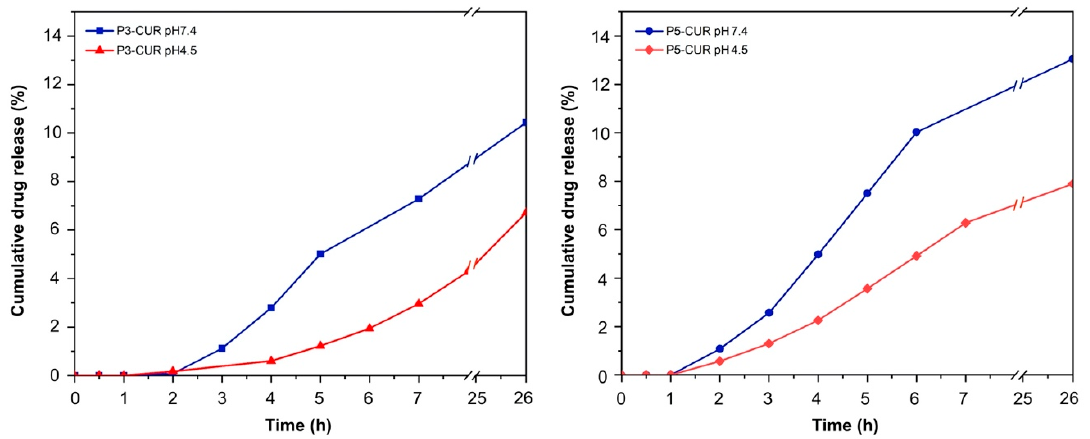
Figure 2. In vitro release curves of curcumin from the P3- and P5 complexes.